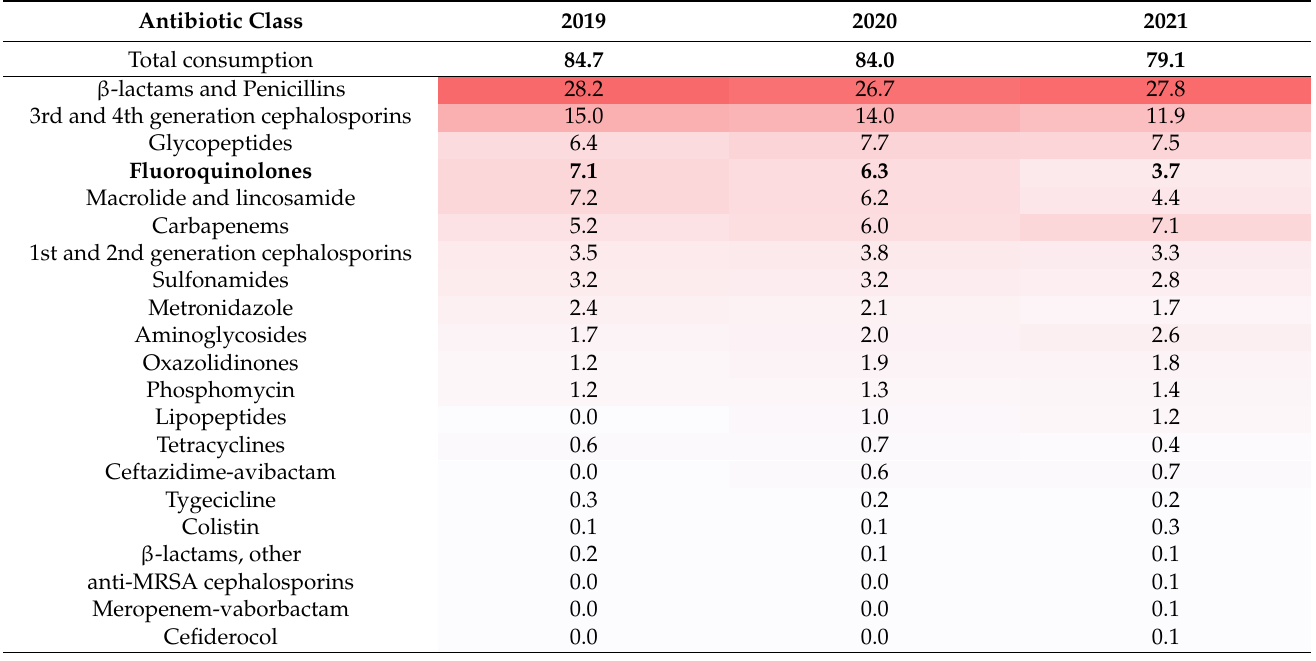
Table 1. Heat Map—antibiotic consumption in defined daily doses (DDDs)/100 bed days at the Siena University Hospital.